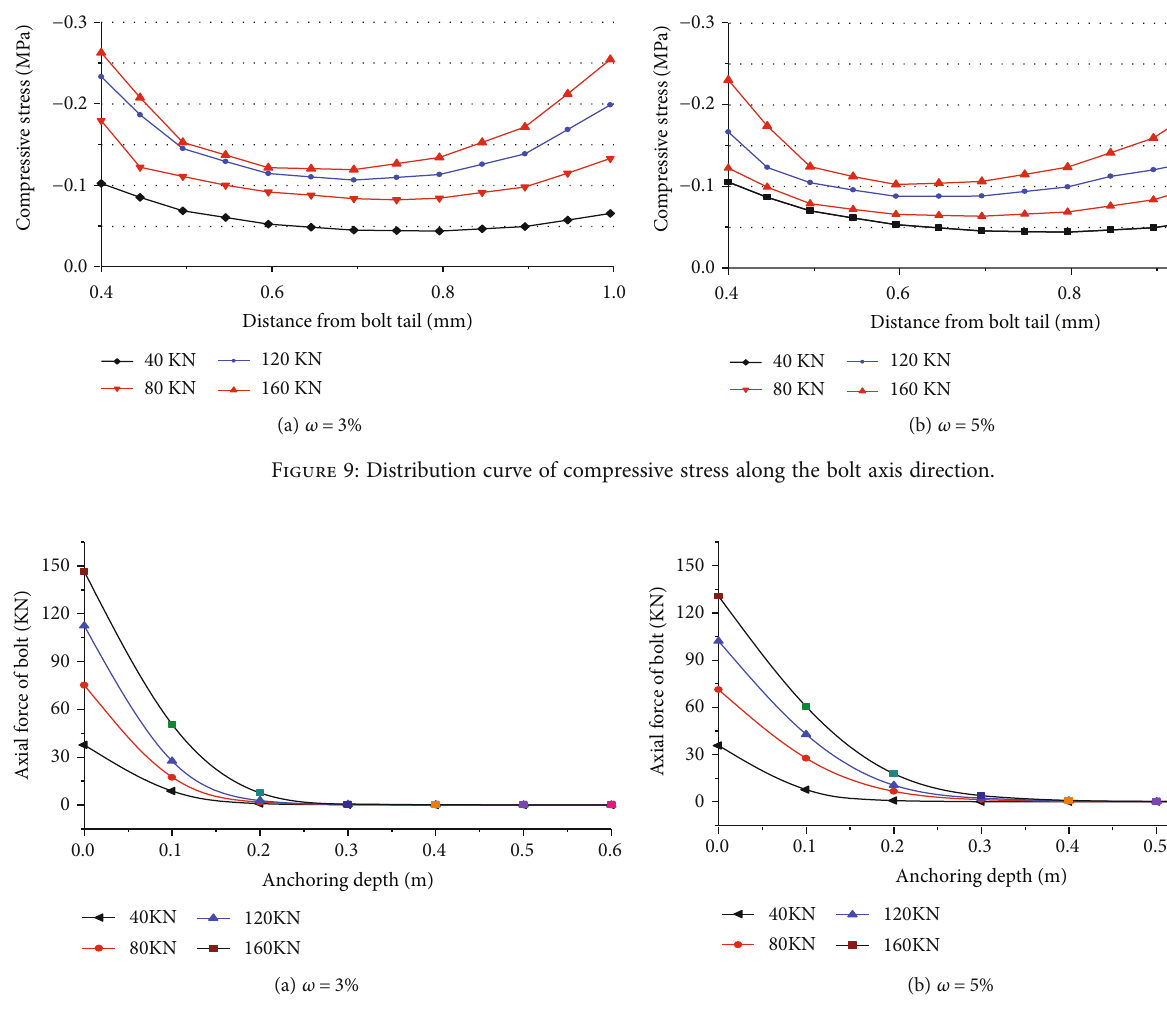
Figure 12: the distribution of compressive stress along the axial direction of the anchor rock of the free section is the same under di ff erent water contents and anchor lengths, and the maximum compressive stress decreases signi fi cantly with the increase of the water content. The compressive stress of each anchorage length at 0.2 m from the tail of the bolt is 1.4-1.6 MPa when the water content is 3%, and the compressive stress is 0.9-1.1 MPa when the water con- tent is 5%. The higher the water content, the smaller the range of compressive stress. The positions of compressive stress greater than 0.2 MPa in the model are 0.7 m and